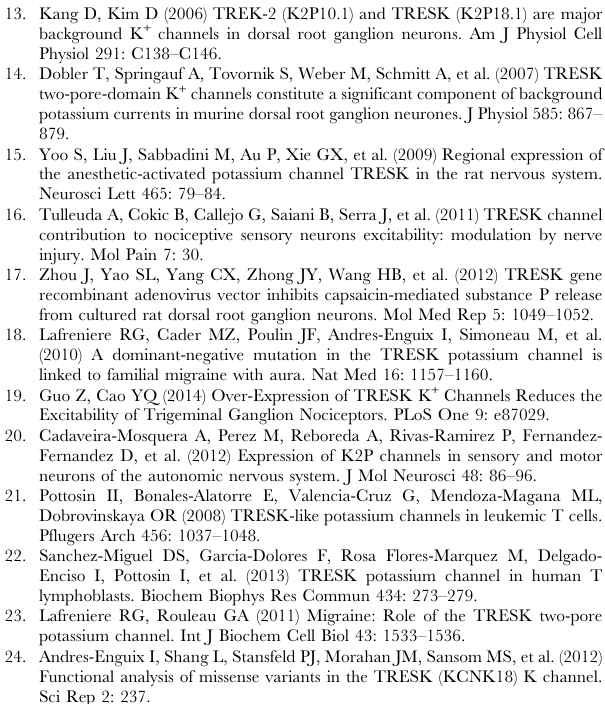
Figure S3 Statistical evaluation of the binding of tubulin to the cytoplasmic loop of TRESK by Coomassie Blue staining and densitometry. A. Four pairs of independent pull- down assays were performed from mouse brain cytosol with the GST fusion protein containing residues 174–280 of human TRESK ( even lanes) or with glutathione agarose ( odd lanes).